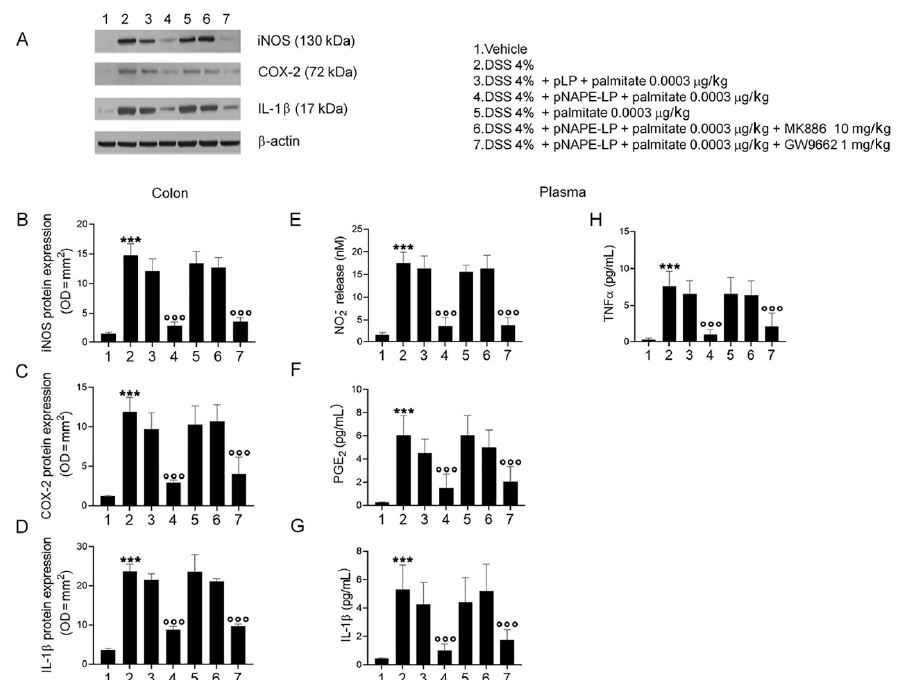
Figure 3. PEA release by pNAPE-LP + palmitate decreases pro-inflammatory mediators’ expression in the mouse colon and their release in the plasma through a selective PPAR α involvement in DSS-treated mice. The administration of pNAPE-LP associated to palmitate (0.0003 μ g/kg) induced a significant reduction in iNOS, COX-2 and IL-1 β protein expression, as well as NO, PGE 2 , IL-1 β and TNF α levels through PPAR α -dependent involvement in mice colon and plasma. ( A ) Western blot analysis of iNOS, COX-2 and IL-1 β protein expression and ( B – D ) relative densitometric analysis (arbitrary units normalized on the expression of the housekeeping protein β -actin). ( E – H ) Respective quantification of NO 2- , PGE 2 , IL-1 β and TNF α levels in mice plasma showing the effects of pNAPE-LP associated to palmitate (0.0003 μ g/kg), given alone or in the presence of MK886 (10 mg/kg) or GW9662 (1 mg/kg) in the colonic tissue of DSS-treated mice. Results are expressed as the mean ± SD of n = 5 experiments performed in triplicate. *** p < 0.001 versus vehicle; °°° p < 0.001 versus DSS-treated mice.